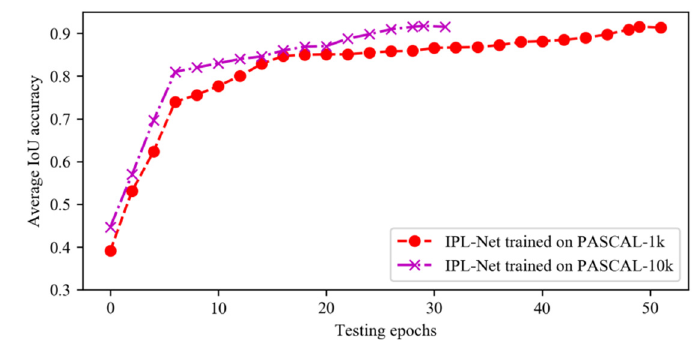
Figure 4. The average IoU accuracy on PASCAL val set.